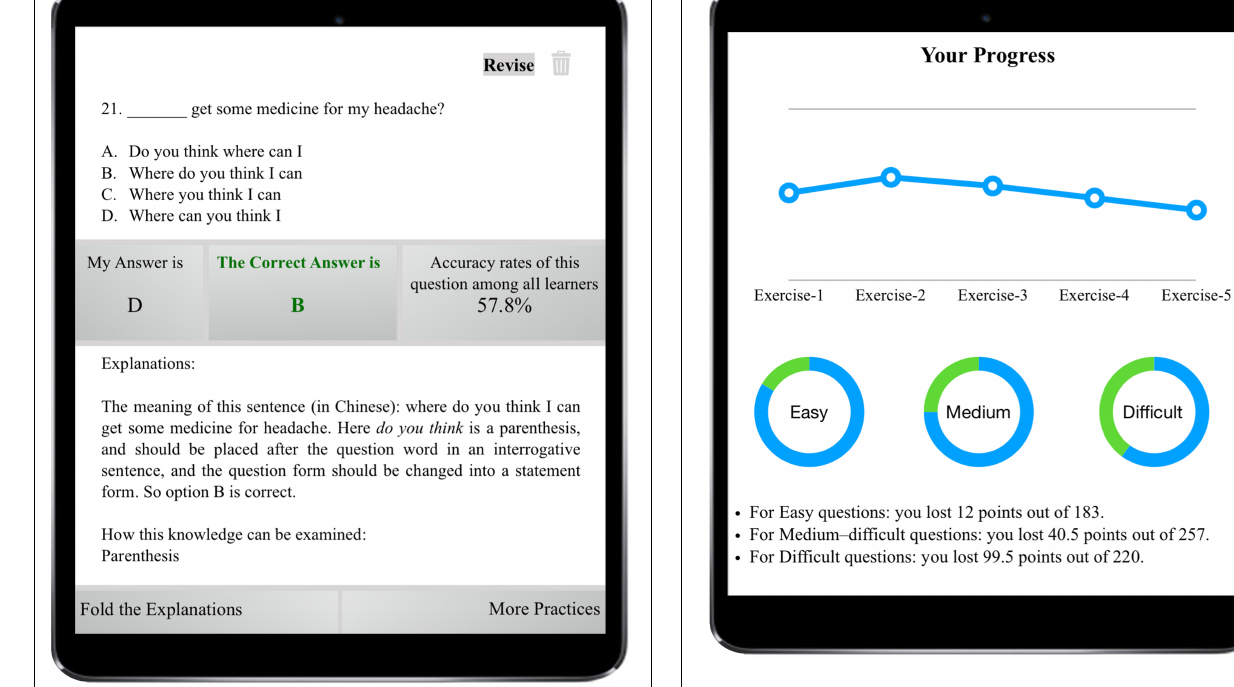
FIGURE 4 | User interface of monitoring progress.